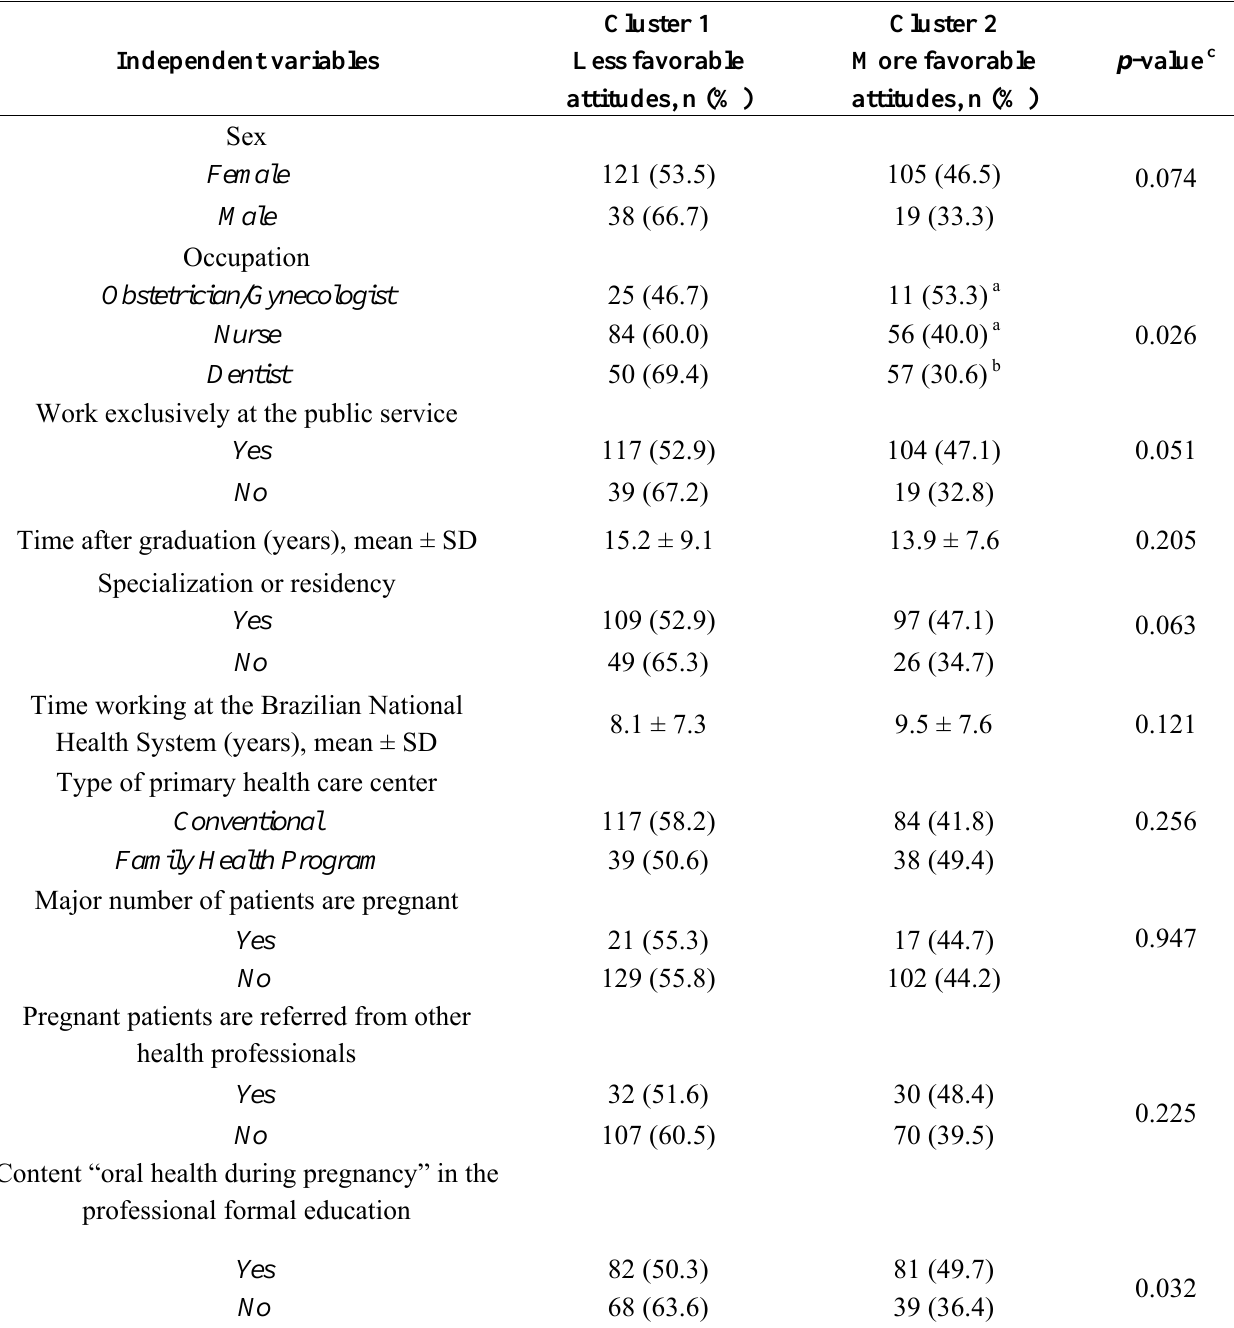
Table 2. Association between attitudes towards oral health during pregnancy and